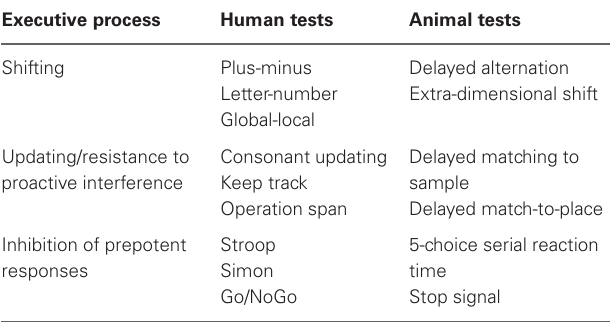
Table 1 | Executive processes and associated tests for use in humans and animal